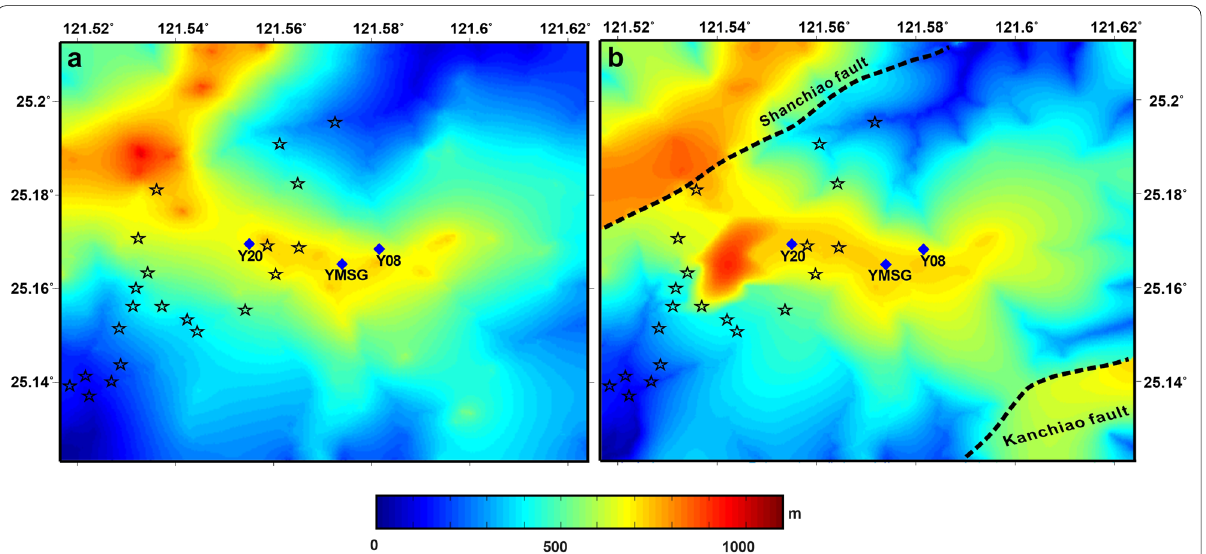
Fig. 4 The modeled groundwater levels in April 2012 from Models A ( a ) and B ( b ). The locations of the groundwater wells are indicated by